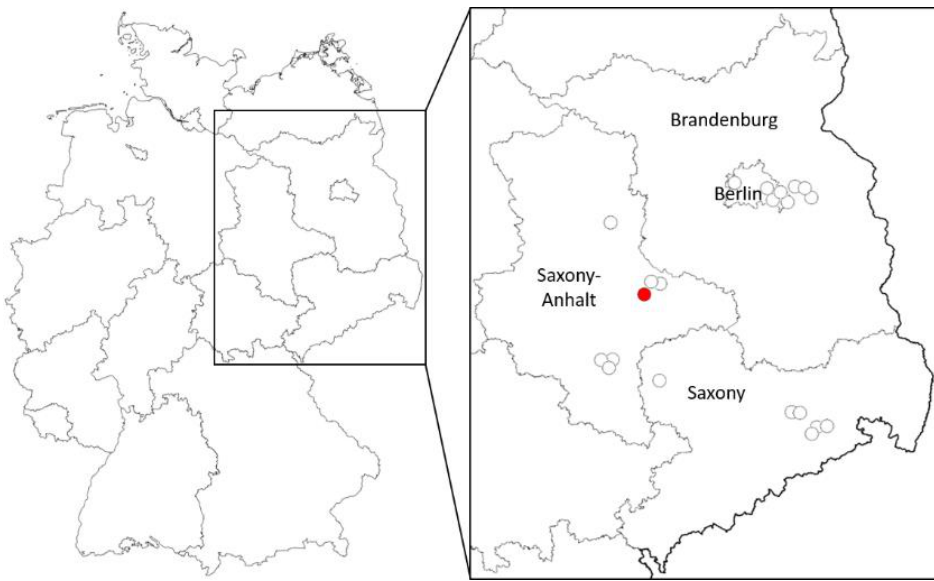
Figure 1. Locations in Germany with detected WNV overwintering (red dot) and of collection sites without virus detection (uncolored dots). without virus detection (uncolored